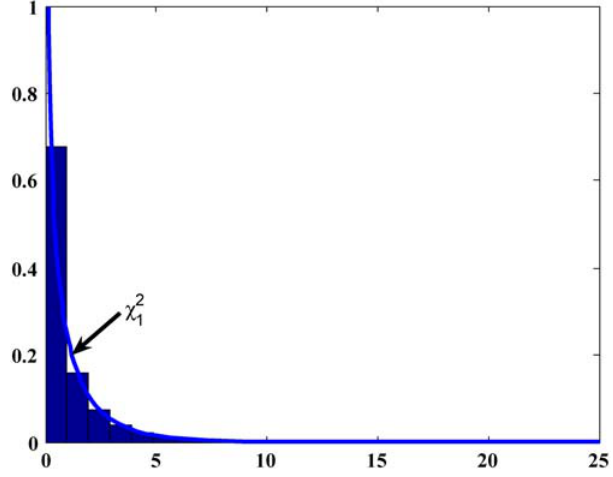
for 400 cases 2 E